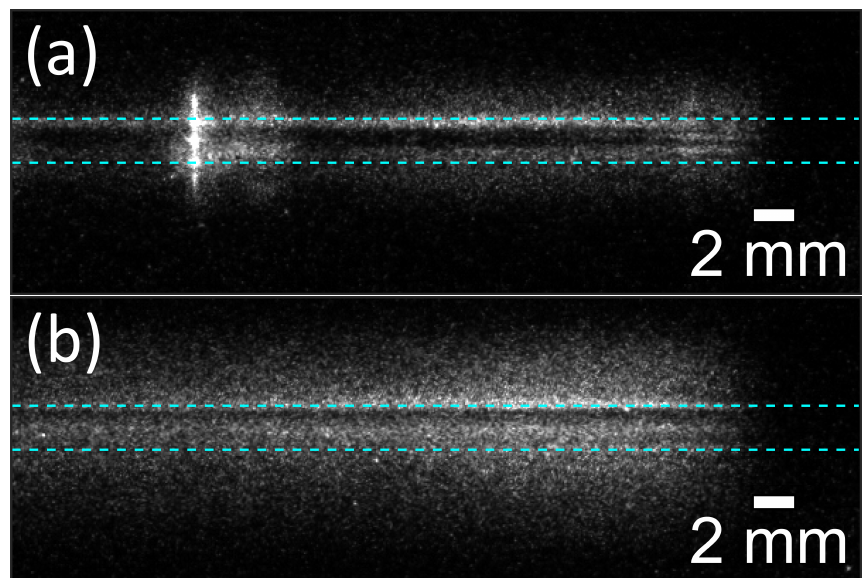
Figure 1. The single-shot images of the discharge half-period of the discharge generated in the nitrogen-monomer mixture: ( a ) transient homogeneous-filamentary regime; ( b ) homogeneous regime without filaments. The dashed blue lines indicate the position of the surface of the dielectric plate covering the upper electrode, and the position of the bottom electrode, which is covered by the glass